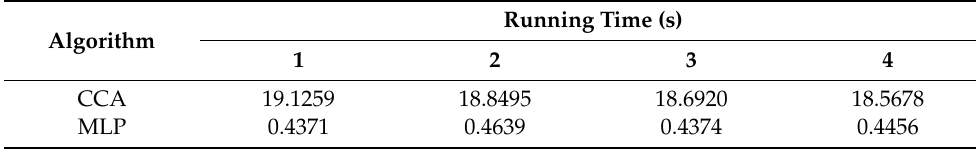
Figure 11. ( a ) Mean absolute error of multilayer perceptron and cross-correlation algorithm at strain from 2500 to 2900 µ ε ; ( b ) confusion matrix of multilayer perceptron. Table 1. Running time of MLP and CCA. Table 1. Running time of MLP and